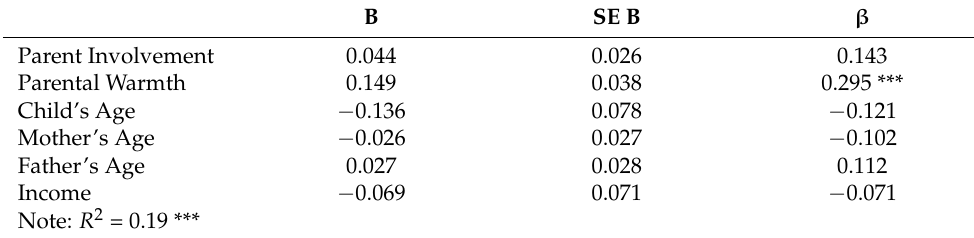
Table 10. Regression including demographic predictors—achievement.